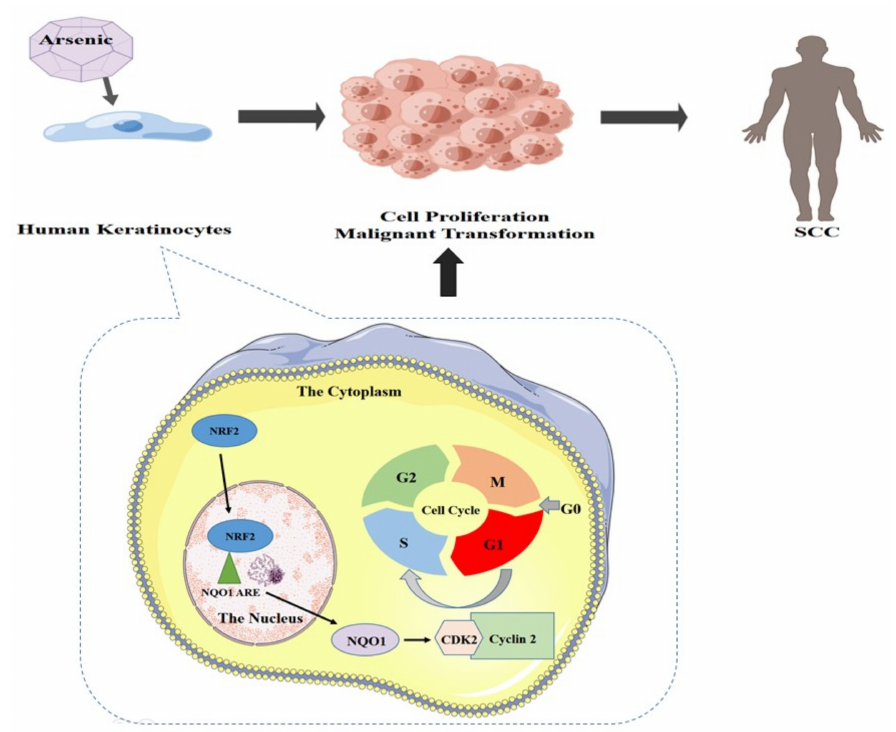
Figure 7. Proposed model by which NRF2 regulates NQO1 to promote proliferation in arsenite- induced malignant